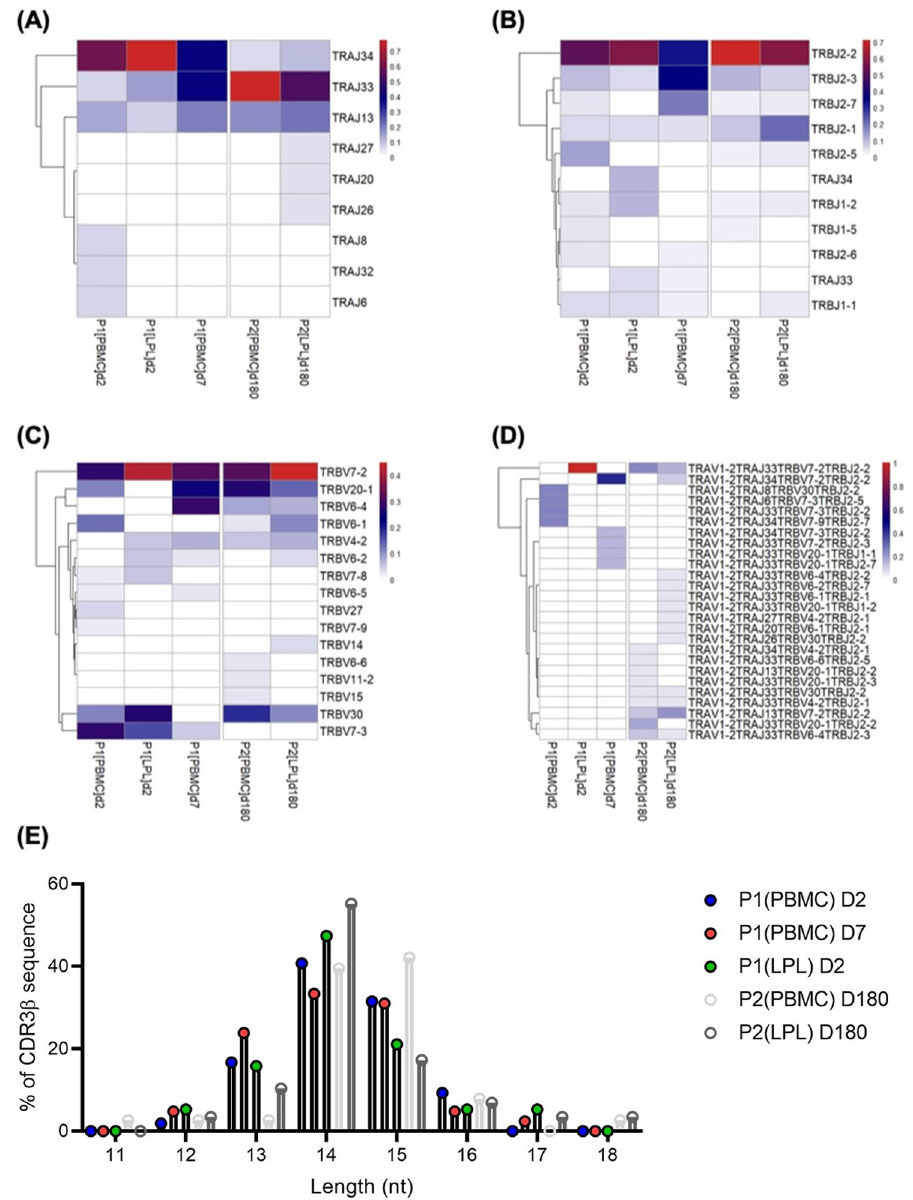
Fig 4. Different distribution of MAIT TCR in LPL compared to PBMCs. MAIT cells were sorted from LPL and PBMCs from two (n = 2) patients at the acute and convalescent stage of illness and TCR usage was analyzed at the single-cell level using Illumina MiSeq sequencing. (A) Paired MAIT TCR αβ usage in each patient is shown as a heat map with hierarchical clustering performed using Euclidean distance. (B, C, and D) TRAJ, TRBV and TRBJ usage in LPL and PBMCs is shown as heat map. (E) The length distribution of MAIT CDR3 β sequence in LPL and PBMCs is shown as a bar graph. The x axis shows length distribution of amino acids and the y axis shows percentage frequency of CDR3 β sequence found with that amino acid